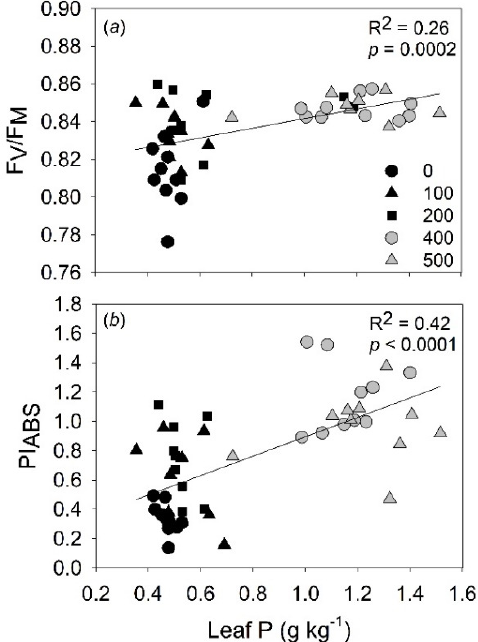
Figure 2. Influence of leaf phosphorus on photochemical efficiency of PSII ( a ) and performance index ( b ) of Bertholletia excelsa saplings in a P-deficient Amazonian Ferralsol. The application of 200 mg P kg − 1 in the soil leads to increased net photosynthesis ( P N ), dark respiration ( R d ), stomatal conductance ( gs ), and transpiration ( E ) (Figure